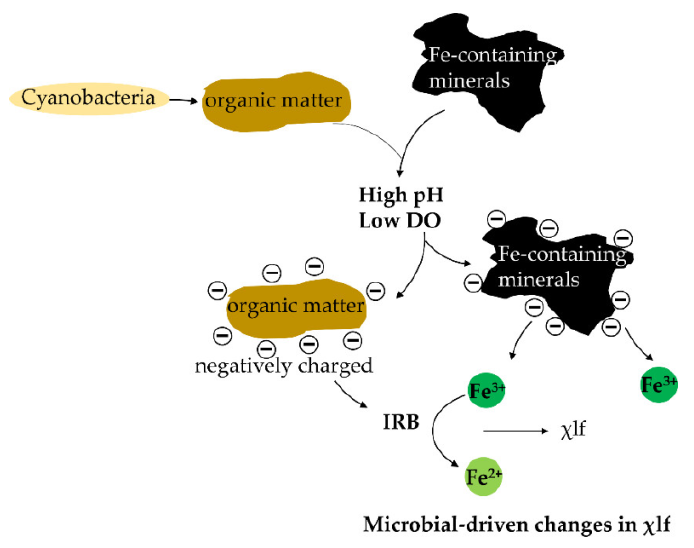
Figure 6. Iron reducing bacteria (IRB)-driven changes in low-frequency susceptibility ( χ lf). DO, dissolved